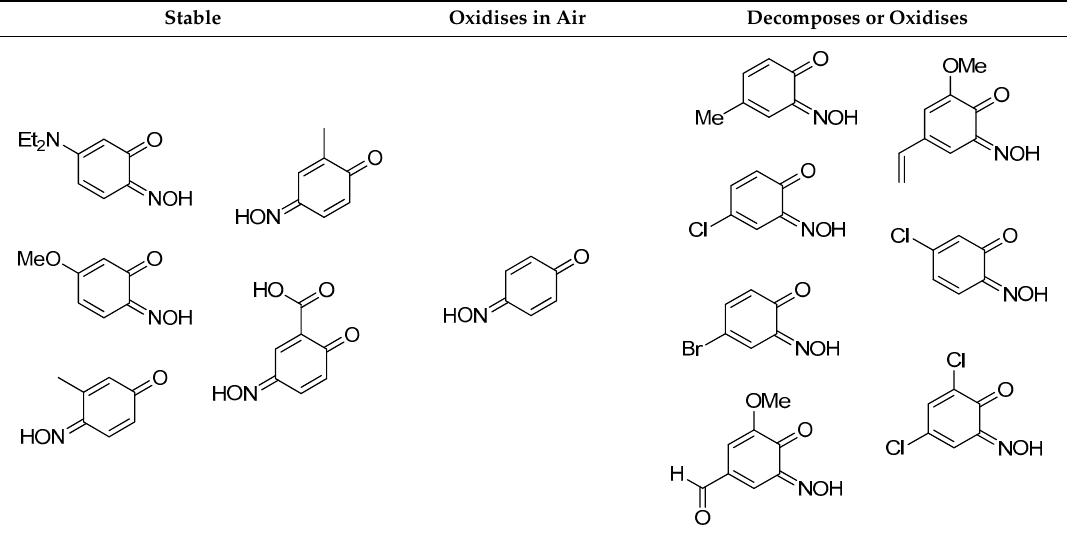
Table 3. The categorisation of nitrosophenol compounds identified in this study according to their stability.